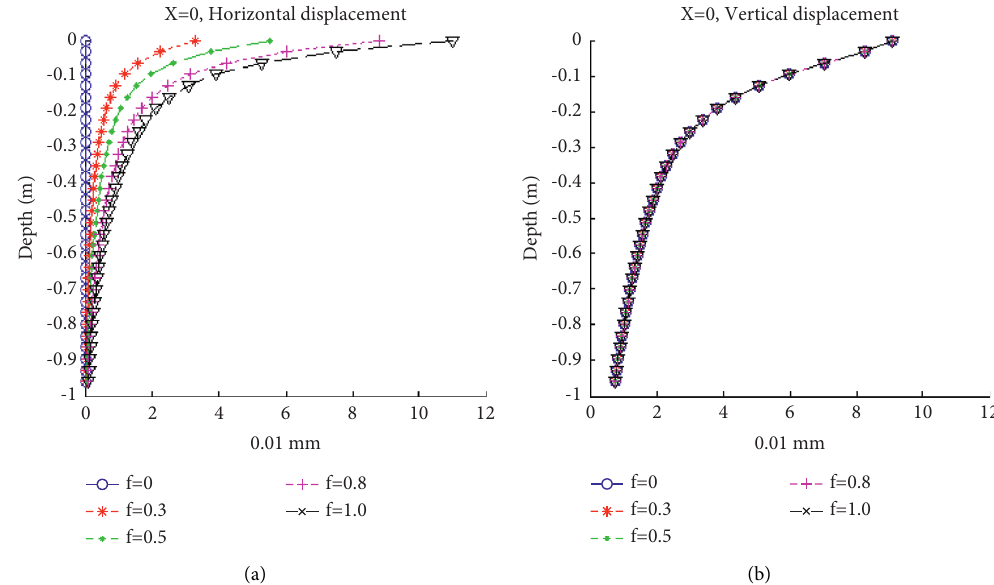
Figure 12: Calculation result of center point displacement of single circular load in z -axis ( x � 0). (a) Calculation result of center point horizontal displacement of single circular load in z -axis ( x � 0). (b) Calculation result of center point vertical displacement of single circular load in z -axis ( x �